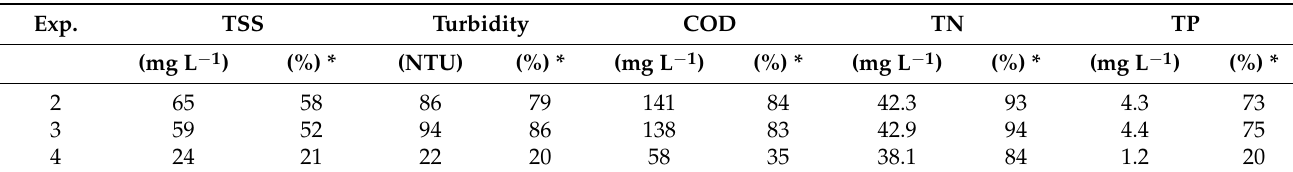
Table 4. Permeate